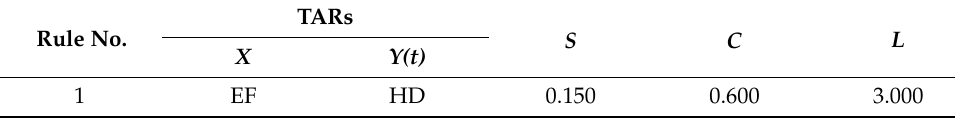
Table 9. TAR results for cruise ships.